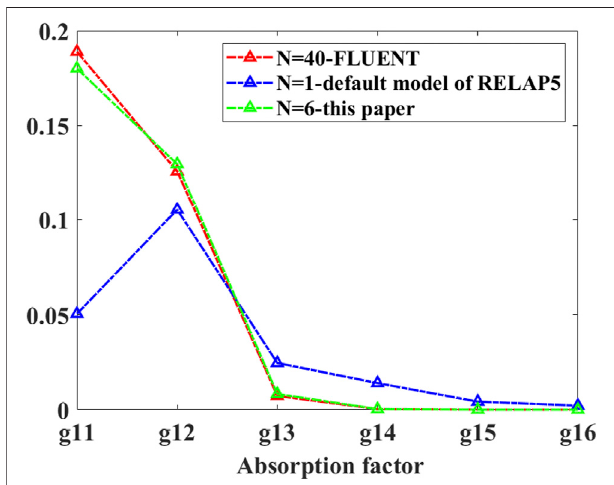
Frontiers in Energy Research |